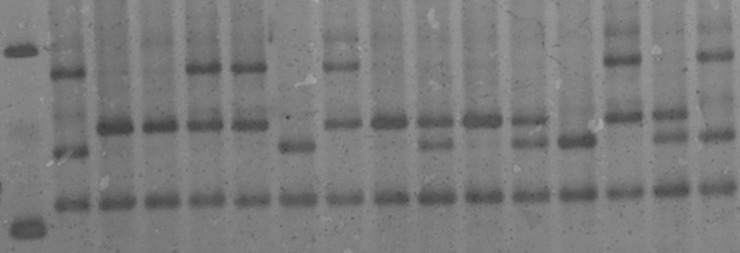
PCR amplification patterns of 15 Callosobruchus chinensis individuals from QD population using primer CCM46 (the left lane 1 is the 100 bp DNA ladder).